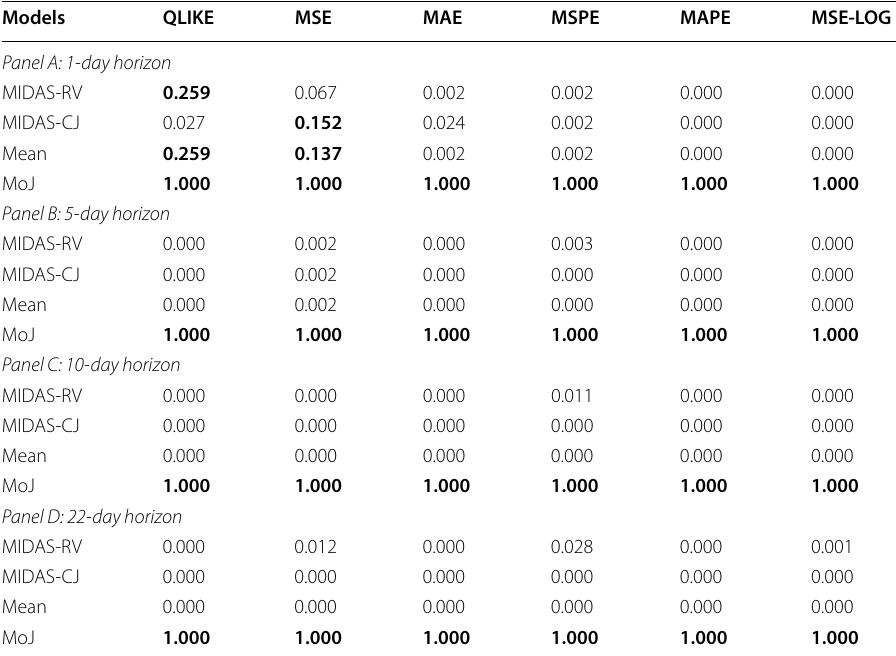
Table 9 MCS out-of-sample test based on the MIDAS-RV and MIDAS-CJ